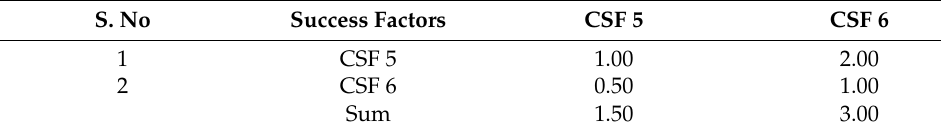
Table 20. Pairwise comparisons for integration level success factors.